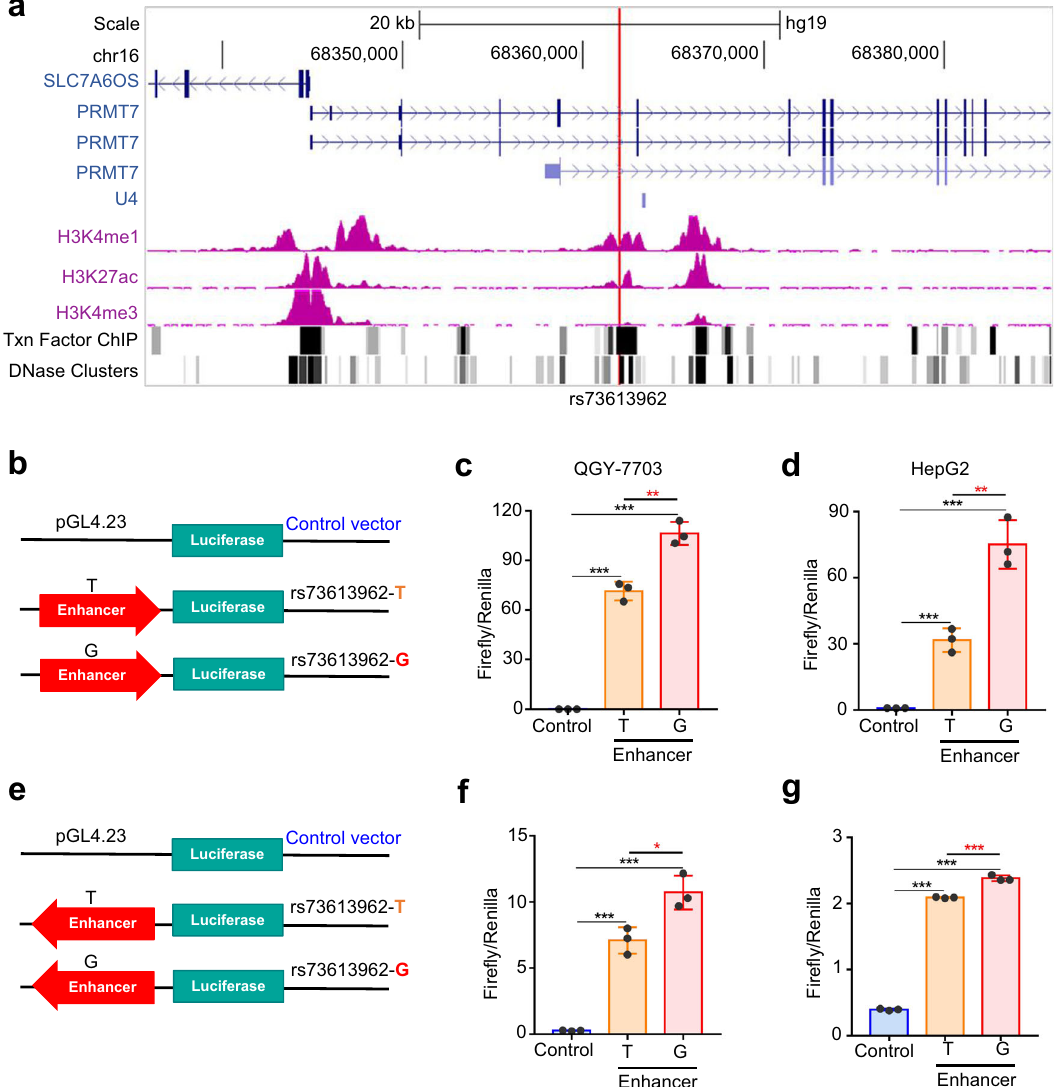
Fig. 2 The rs73613962-containing region has an enhancer signal and allele-speci fi c enhancer activity. a Overview of the H3K4me1, H3K27ac, and H3K4me3 chromatin modi fi cations, the binding sites of transcription factors (Txn Factor ChIP), and DNase cluster distribution in the regions surrounding rs73613962 of the HepG2 cell line supported from the UCSC genome browser. rs73613962 is indicated by the red vertical line. b – g The dual-luciferase assays of enhancer activity for the empty vector (Control), and the plasmids with the insertion of the rs73613962-centered region (Enhancer-T and Enhancer-G). Luciferase activity is individually examined when the rs73613962-centered region is inserted in the luciferase vector in the forward ( b – d )